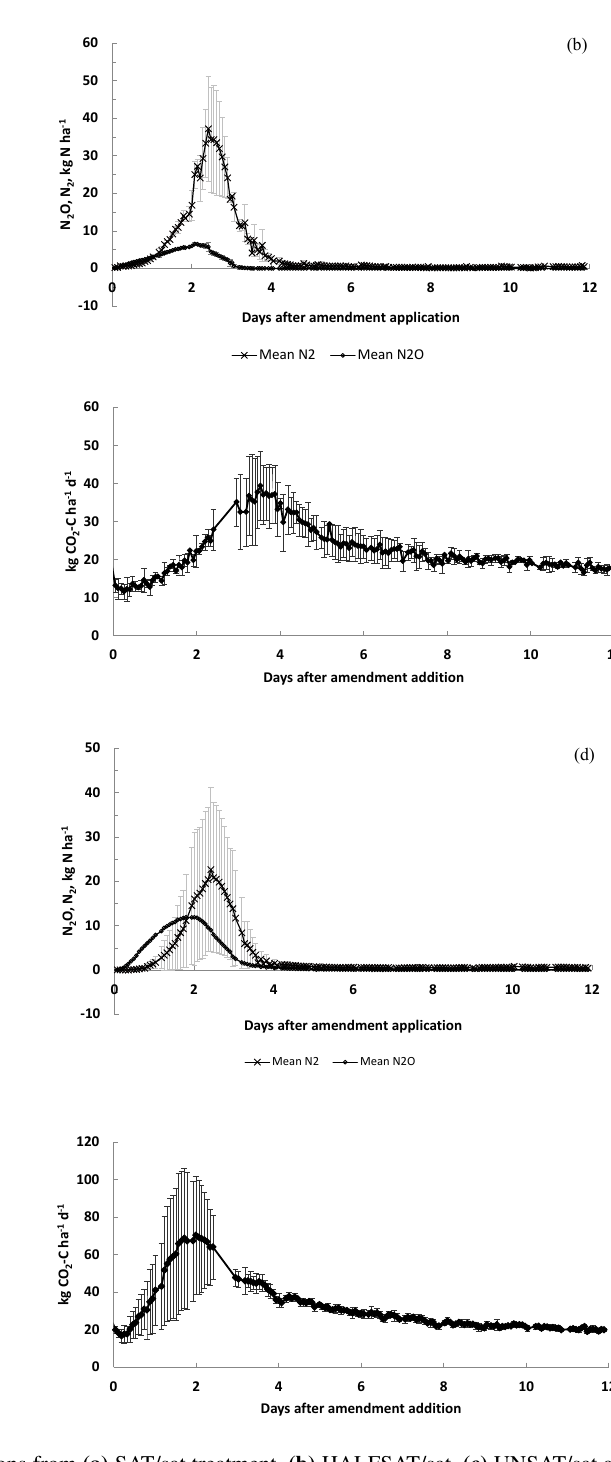
Figure 1. Mean of the three replicates for N 2 O, N 2 and CO 2 emissions from (a) SAT/sat treatment, (b) HALFSAT/sat, (c) UNSAT/sat and (d) UNSAT/halfsat. Grey lines correspond to the standard error of the means (in c and d only errors for the N 2 are shown to avoid overlapping of